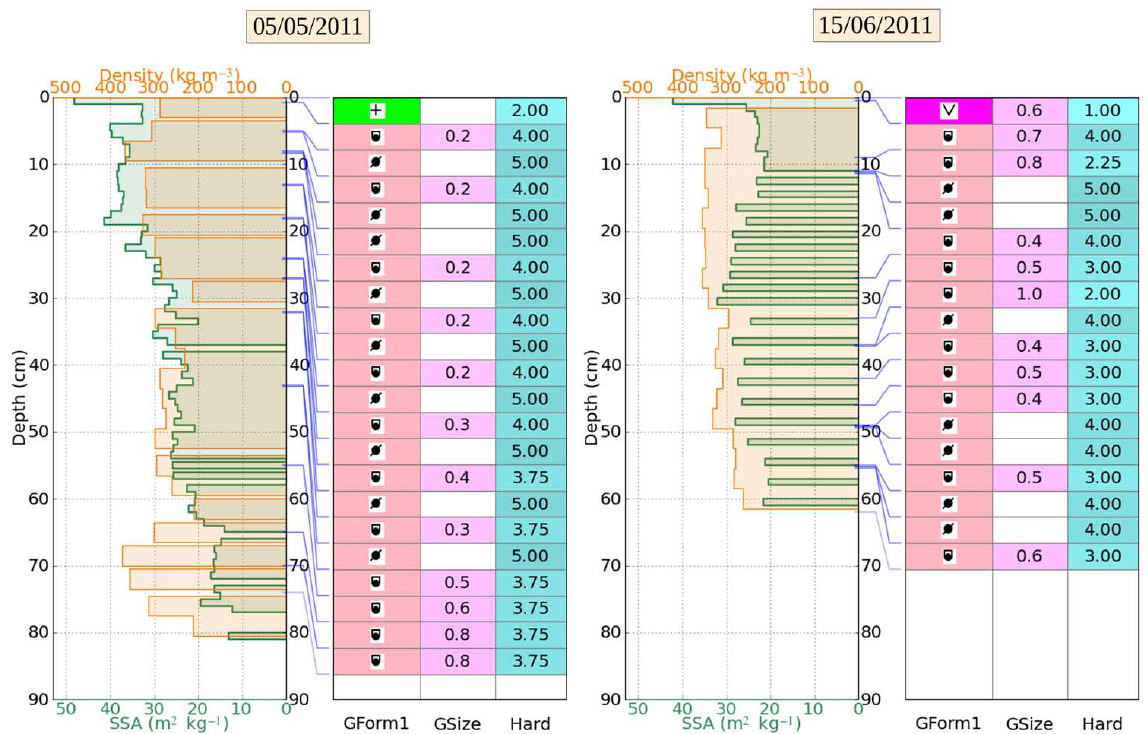
Fig. 8. Vertical profiles of the physical properties of snow, for 5 May (left) and 15 June (right). For each date 2 variables are plotted: orange lines represent density and green lines represent SSA. In the tables, all grain types and sizes (in mm) corresponding to the different snow layers are shown, along with the hand hardness.